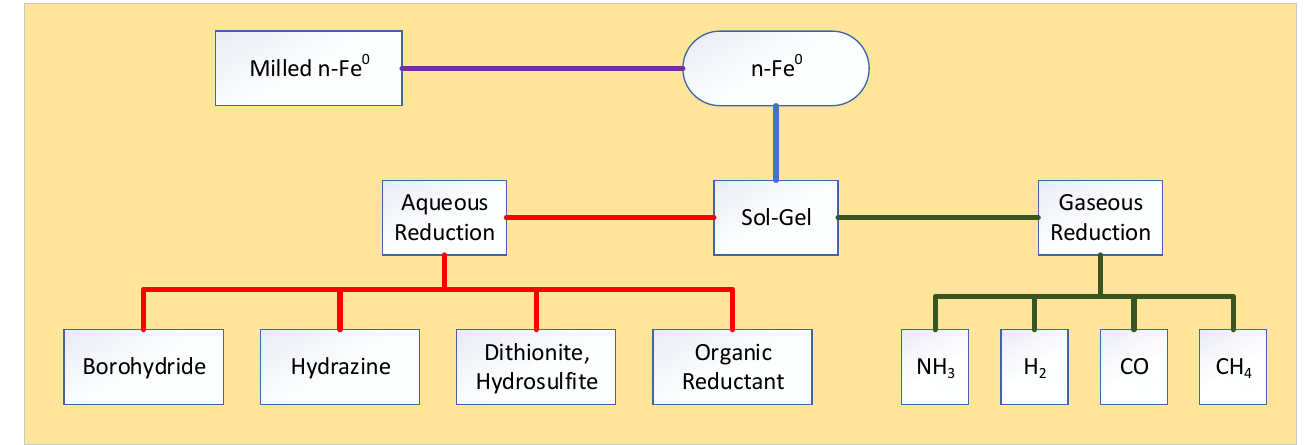
Figure A8. Principal approaches used to manufacture n-Fe 0